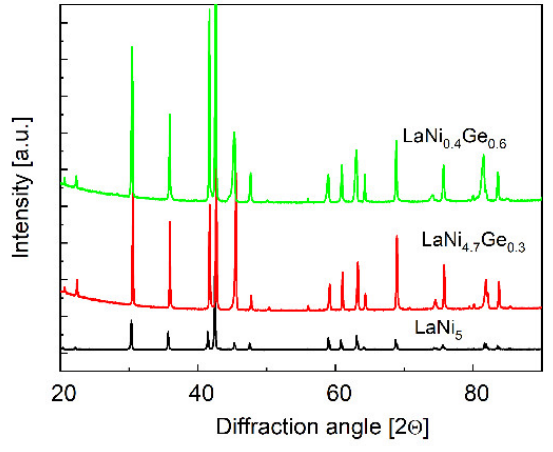
Figure 2. X-ray diffraction patterns taken at room temperature for LaNi 5-x Ge x alloys.